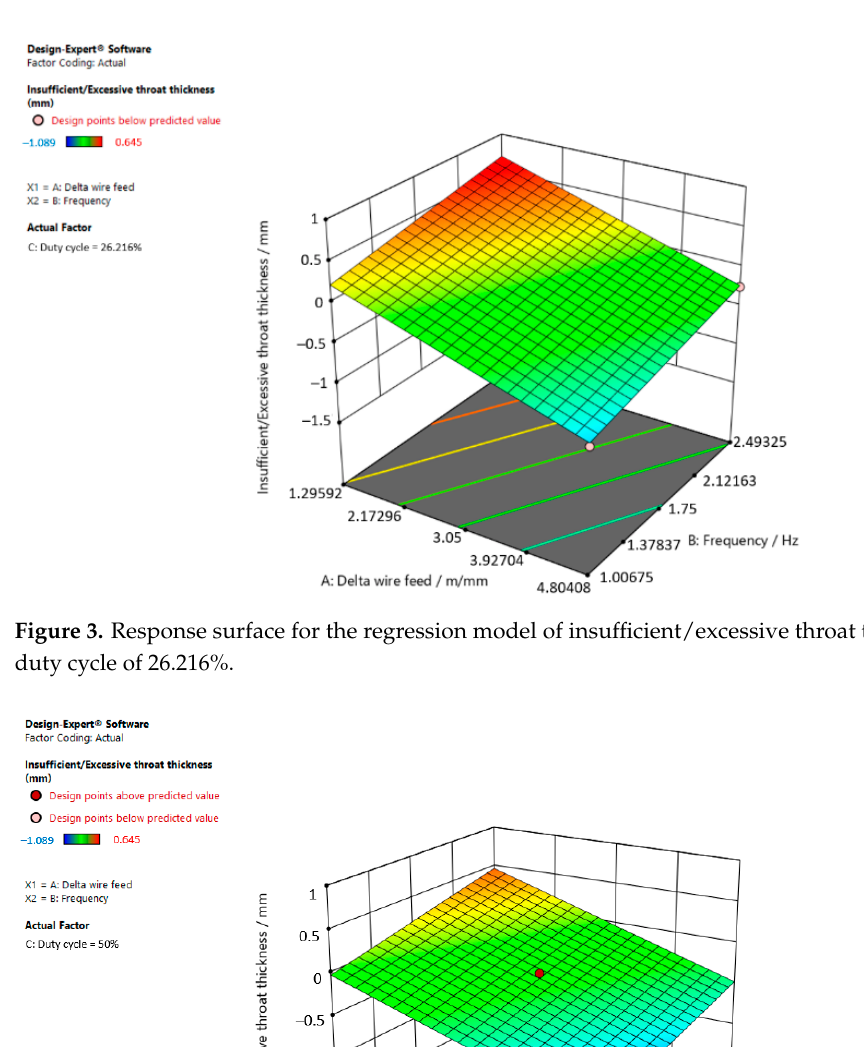
Figure 4. Response surface for the regression model of insufficient/excessive throat thickness at a duty cycle of 50.00%.